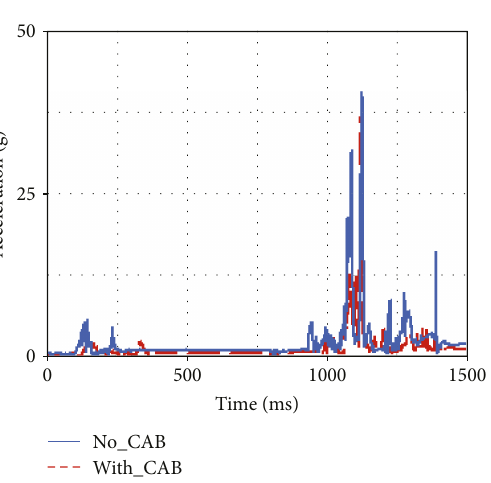
Figure 12: Upper neck F